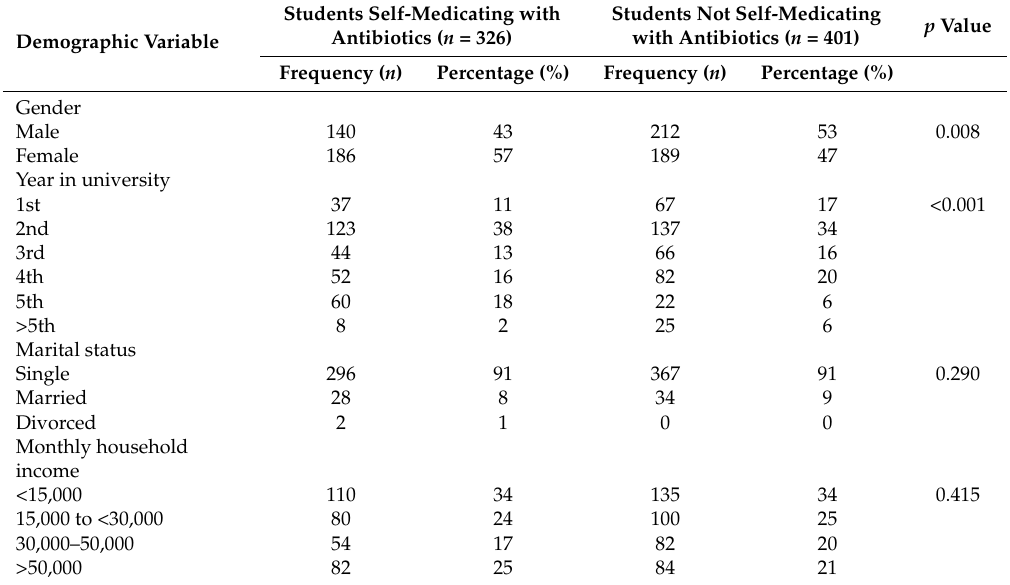
Table 1. The demographic characters and frequency of